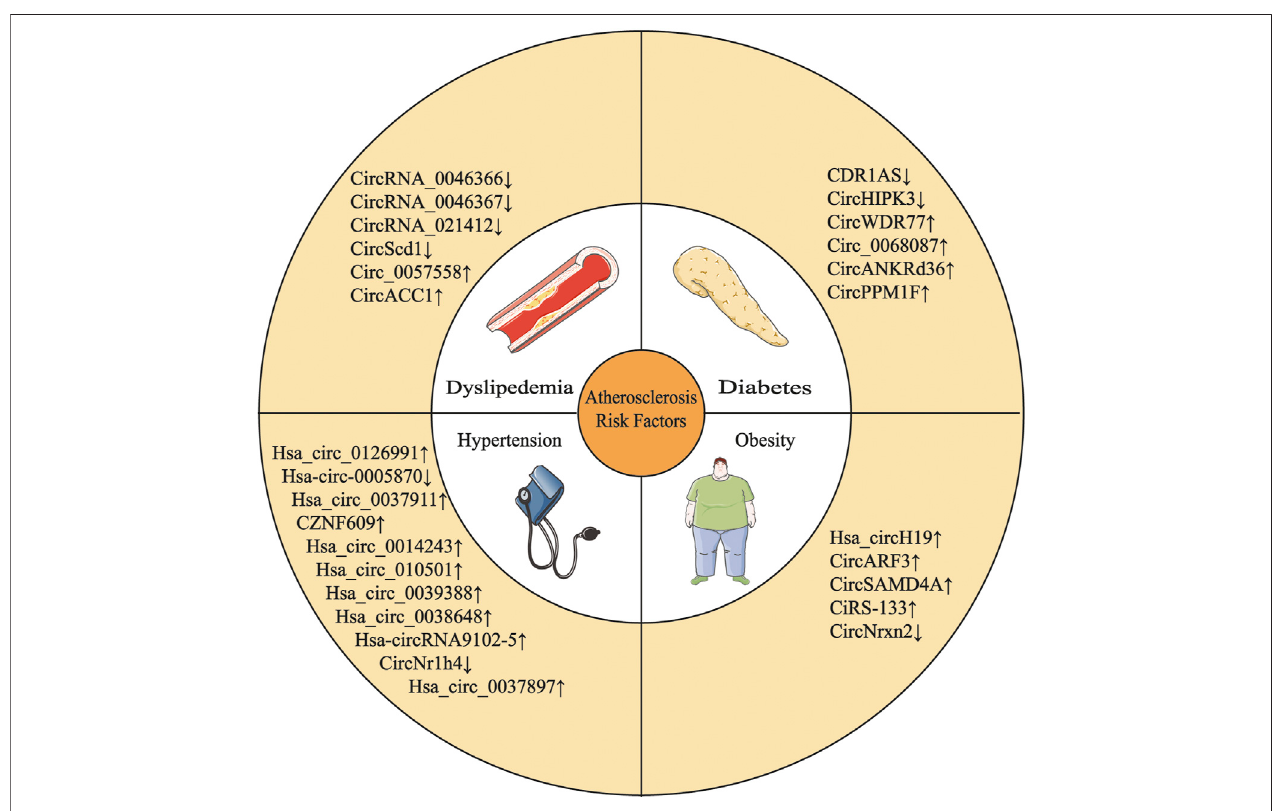
FIGURE 1 | Multiple circRNAs are involved in the development of AS risk factors. ↑ : upregulation; ↓ : downregulation.